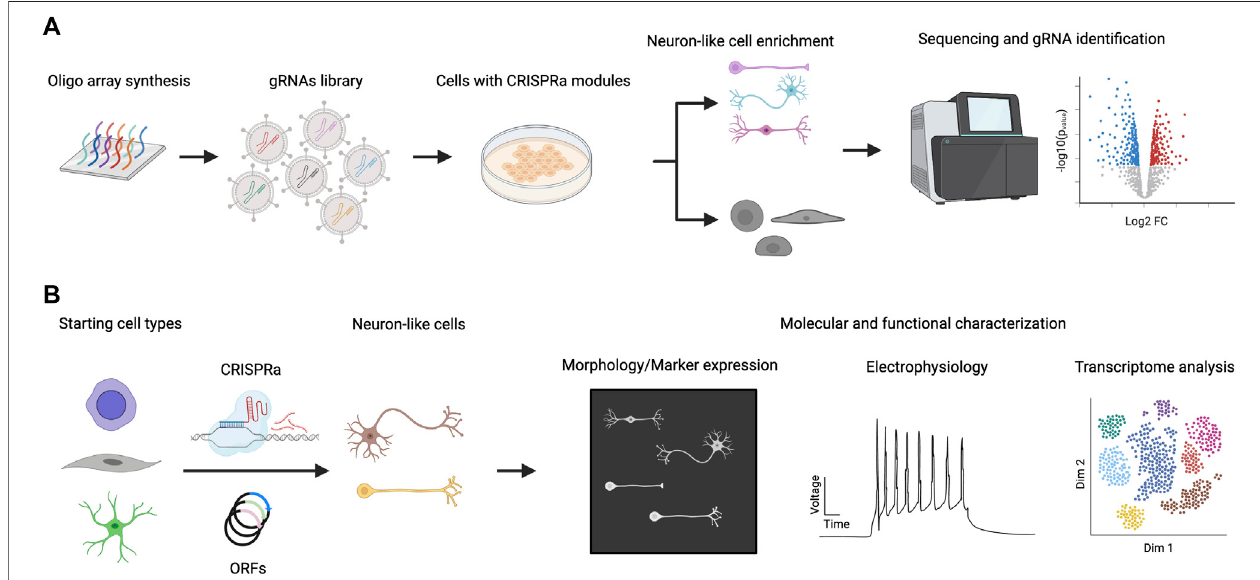
FIGURE2| CRISPRascreenforneuronaldifferentiationanddownstreamcharacterization. (A) AlibraryofgRNAsissynthesized(e.g.chipoligoarraysynthesis)and delivered to cells expressing CRISPRa proteins. Cells that exhibit neuronal characteristics are enriched and their gRNA distribution is compared with non-neuronal populations.gRNAsthatarespeci fi callyenrichedinneuronalpopulationsareconsideredhitsofthescreen. (B) HitsfromCRISPRascreenarevalidatedbyfocusedstudy using gRNAs targeting or ORFs expressing speci fi c genes. Further characterization of the induced neuronal cells includes morphological, electrophysiological and transcriptomic